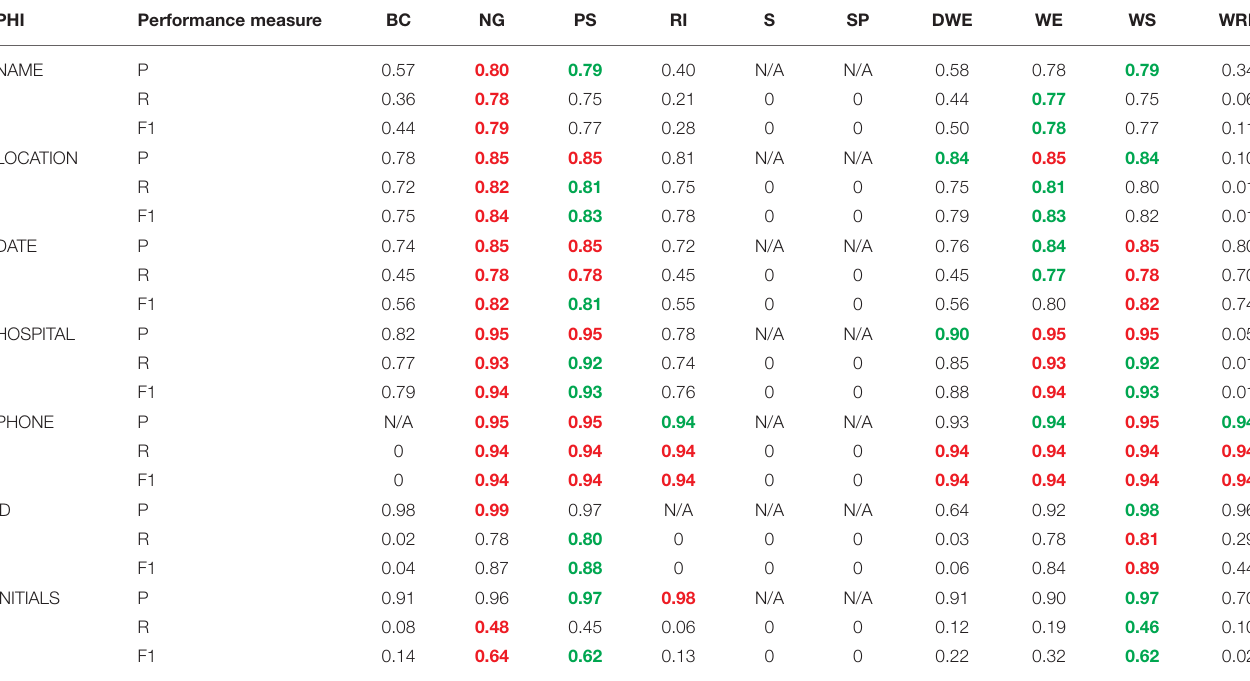
TABLE 1 | Precision, Recall, and F1-score achieved by the models trained by individual feature for each PHI. PHI Performance